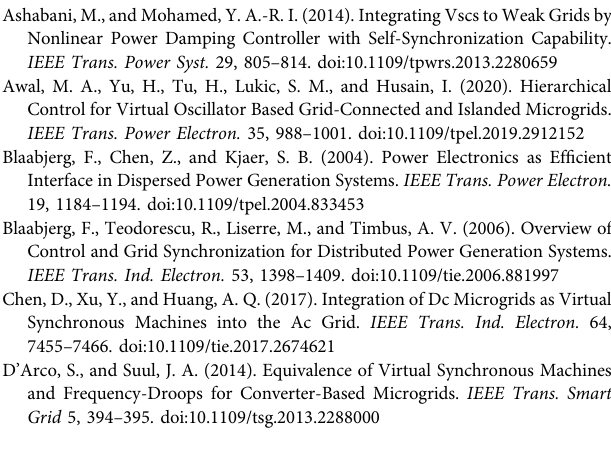
Frontiers in Energy Research |